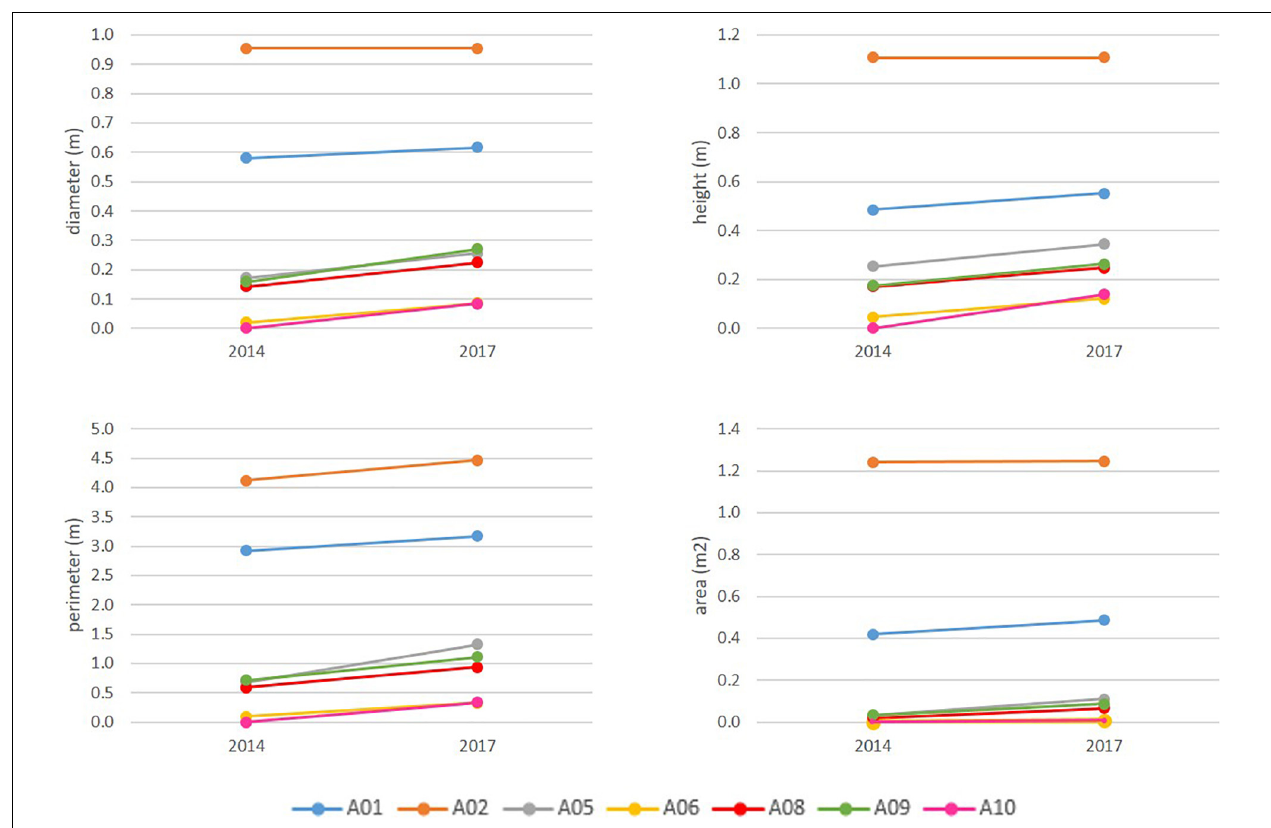
FIGURE 8 | Size reached by the A. setubalense specimens in 2014 and 2017 according to the parameters that define their size. For the A01 size recorded in 2014 and 2019, a linear interpolation was made to calculate its size in 2017.